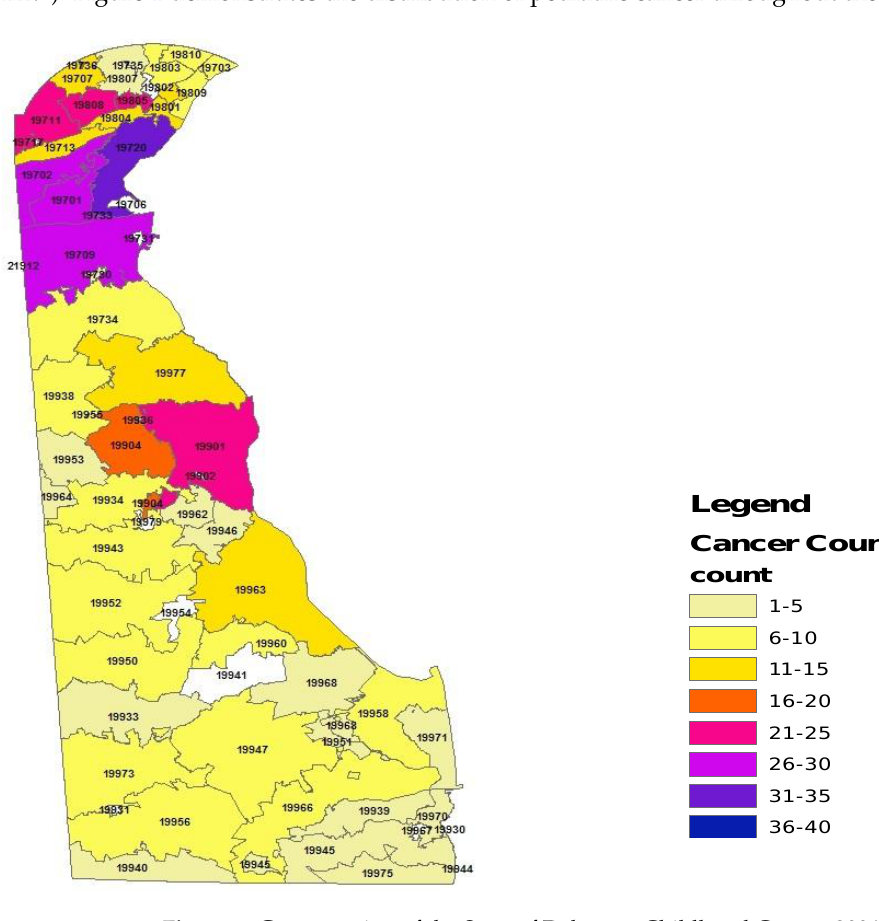
Figure 1. Geo-mapping of the State of Delaware Childhood Cancer,